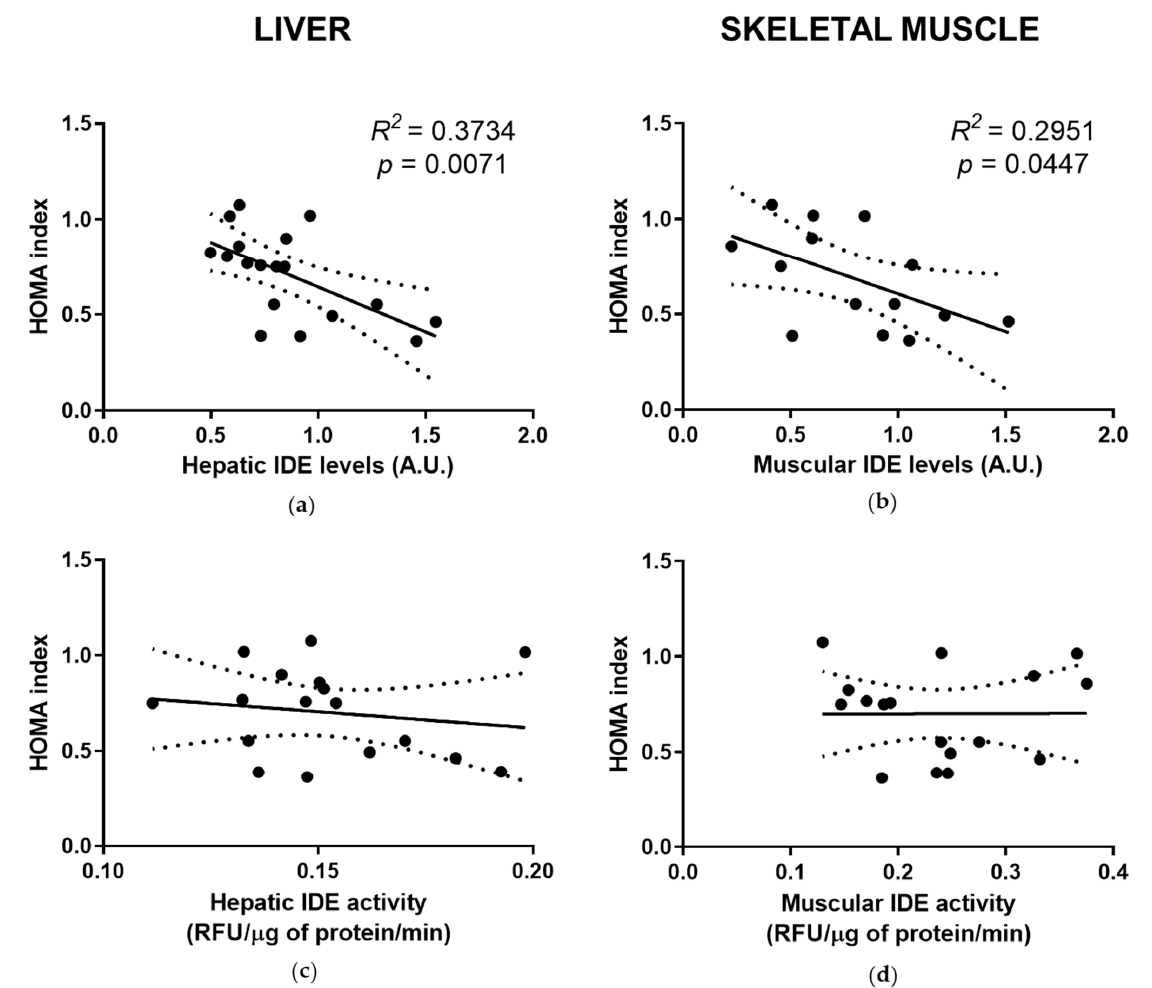
Figure 5. Hepatic and muscle IDE protein levels correlate with a surrogate marker of insulin resistance. IDE protein and activity levels in fasting conditions of mice fed an SD and HFD were assessed as described in Section 2. Bivariate analyses were performed using data from mice fed an SD and HFD under fasting conditions. ( a ) Correlation between hepatic IDE protein levels and HOMA index. ( b ) Correlation between IDE protein levels in muscle and HOMA index. ( c ) Correlation between hepatic IDE activity levels and HOMA index. ( d ) Correlation between muscle IDE activity levels and HOMA index. The R 2 and statistical significances ( p ) values are indicated in the figure.